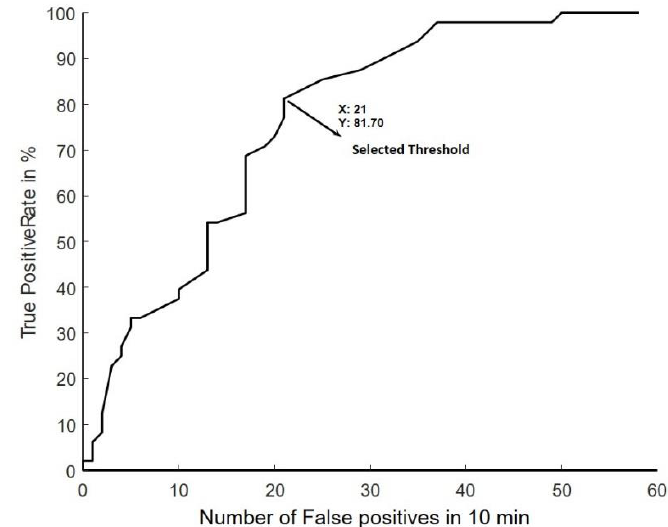
Figure 1. ROC curve, from one training set which was 10 min long to show the trade-off between TPR and FP’s.